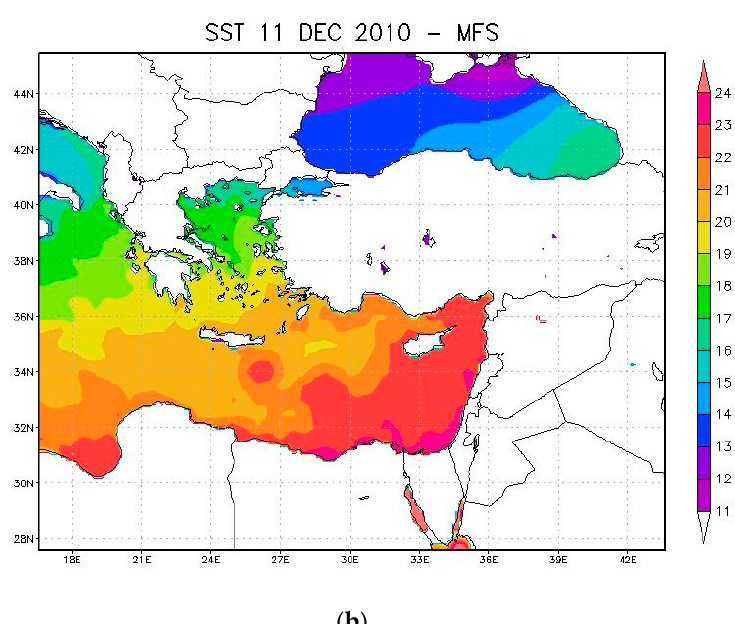
Figure 22. SST (°C) fields on 11 December 2010: ( a ) from the R2 reanalysis and ( b ) the MFS reanalysis for the full model domain.